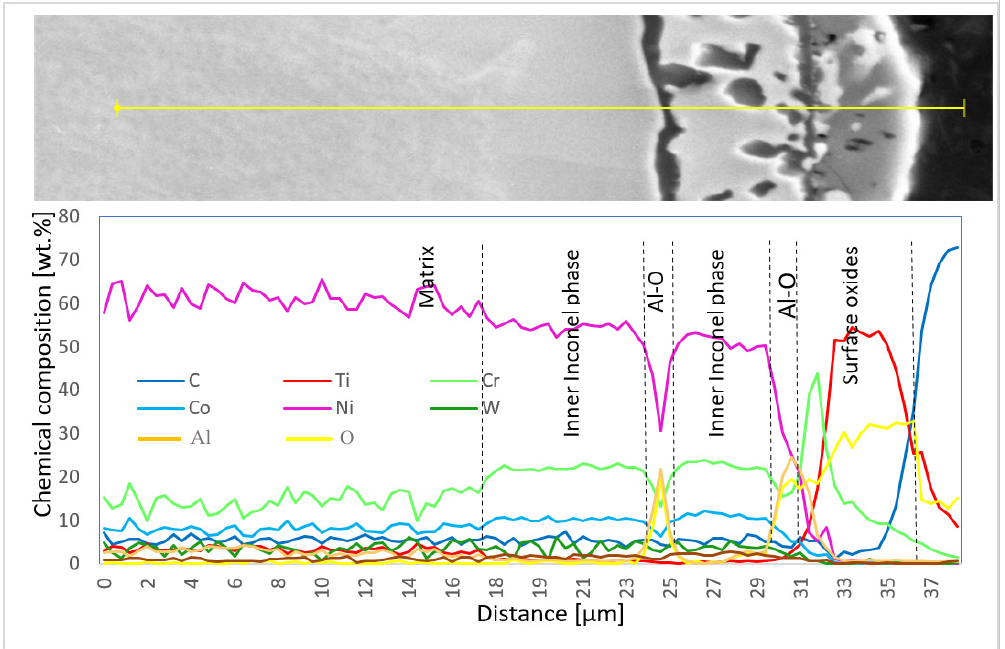
Diagram 3. Chemical composition (wt.%) of elementary lines on the 50R sample after He exposure.